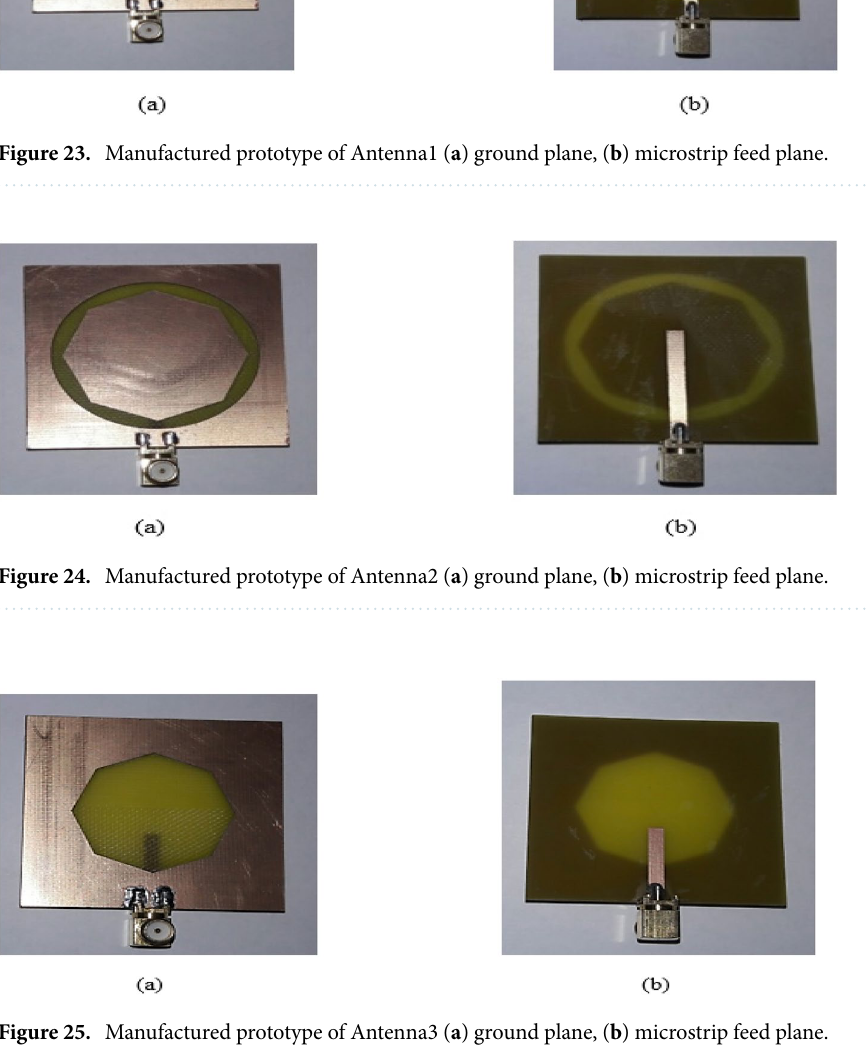
Figure 25. Manufactured prototype of Antenna3 ( a ) ground plane, ( b ) microstrip feed